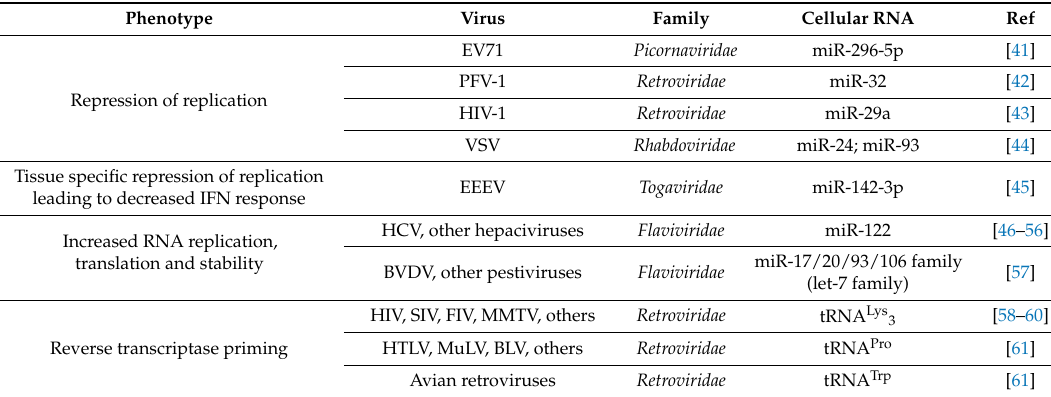
Table 1. Direct interactions between viral and cellular RNA with functional